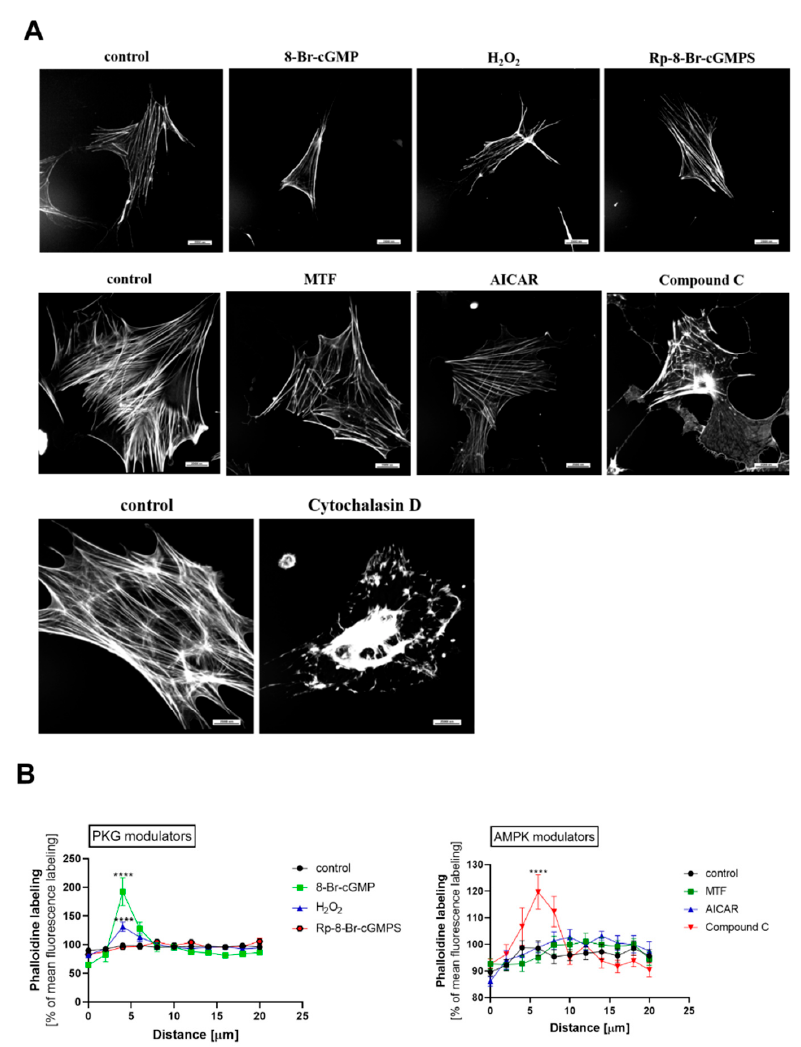
Figure 8. PKGI α and AMPK antagonistically mediate the remodeling of actin filaments in cultured podocytes. Podocytes were seeded on glass coverslips and treated with PKG modulators (8-Br-cGMP, 100 µ M, 5 min; H 2 O 2 , 100 µ M, 5 min; Rp-8-Br-cGMPS, 100 µ M, 20 min), AMPK modulators (MTF, 2 mM, 2 h; AICAR, 100 µ M, 2 h; compound C, 100 µ M, 2 h), or the actin filament disruptor cytochalasin D as a positive control (10 µ M, 30 min). ( A ) The F-actin network was labeled with phalloidin (1:200) and visualized by confocal microscopy; ( B ) Analysis of fluorescence intensity profile (F-actin distribution within the cell was measured as the distance from the basal membrane (0 µ m) to the nucleus (20 µ m)) using Nikon NIS-Elements software. Scale bar = 25 µ m. Objective magnification: 40 × . The data were analyzed using Dunnett’s test and are expressed as the mean ± SEM. n = 11–17. **** p <